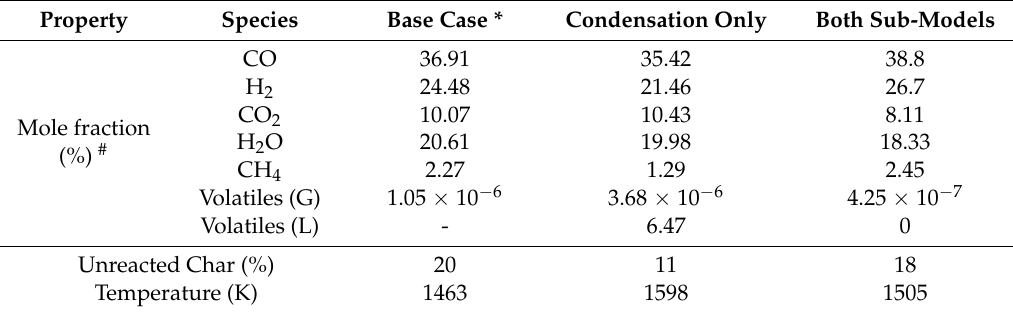
Table 8. Effect of condensation and re-vaporization sub-model.